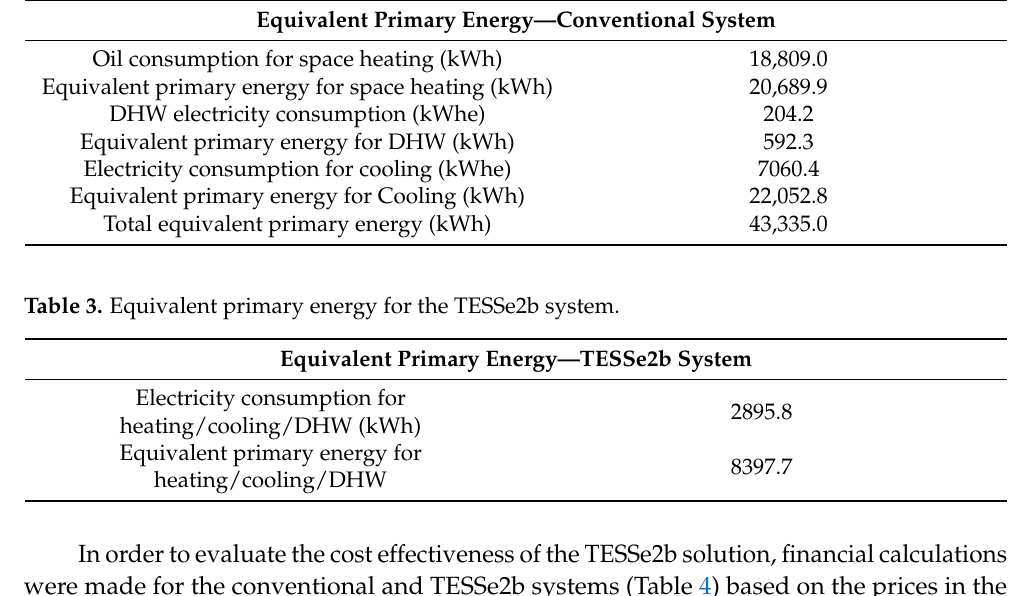
Table 2. Equivalent primary energy for the conventional system.